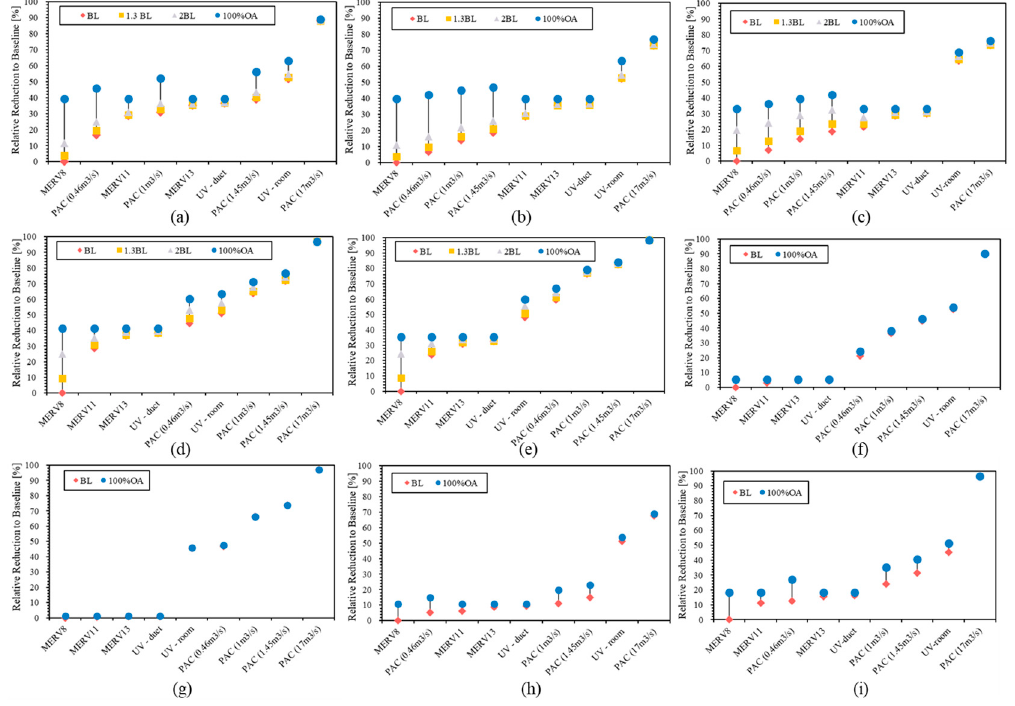
Figure 14. Estimated mitigation strategy risk reduction relative to the baseline case ((P baseline − P strat- Figure egy )/P baseline ): ( a ) Medium Office—Core zone, ( b ) Large Office—Core zone, ( c ) Stand Alone Retail—